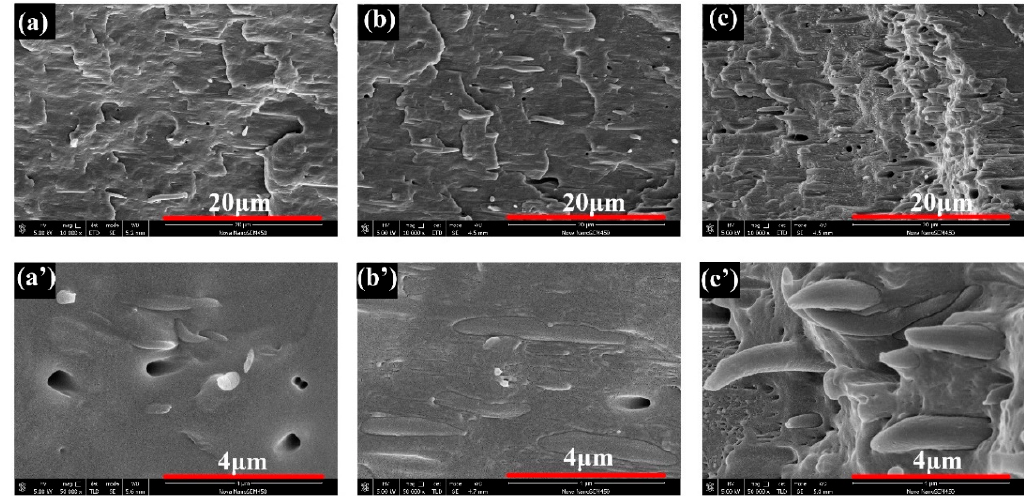
Figure 4. SEM of fracture surface along the flow direction. ( a )/( a’ ) MV5, ( b )/( b’ ) MV10, and ( c )/( c’ ) MV20.